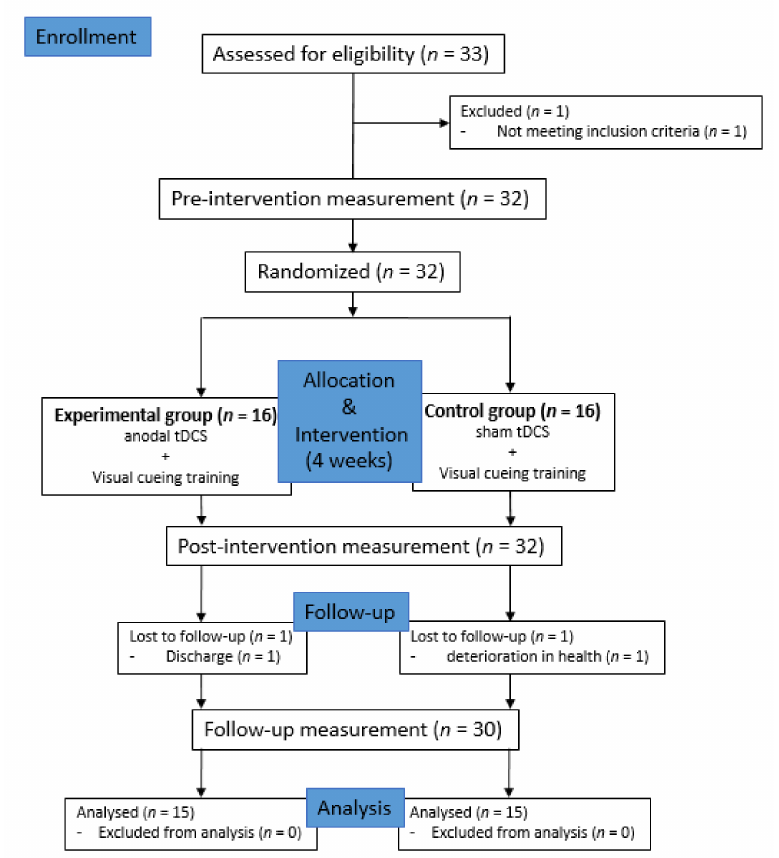
Figure 1. Study flow chart.; Transcranial Direct Current Stimulation